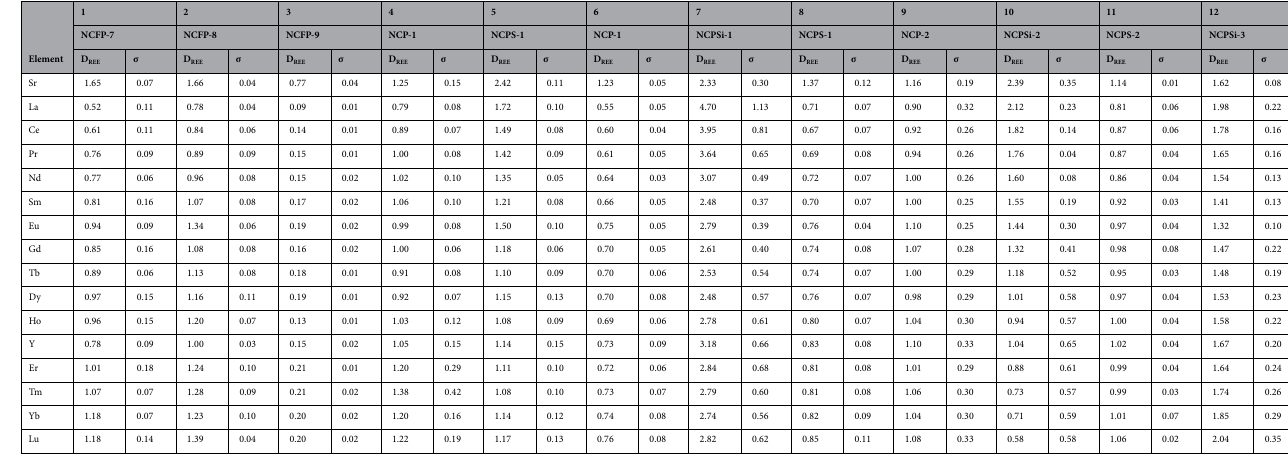
Table 5. Calcite-melt partition coefficients of trace elements. σ the standard deviation.